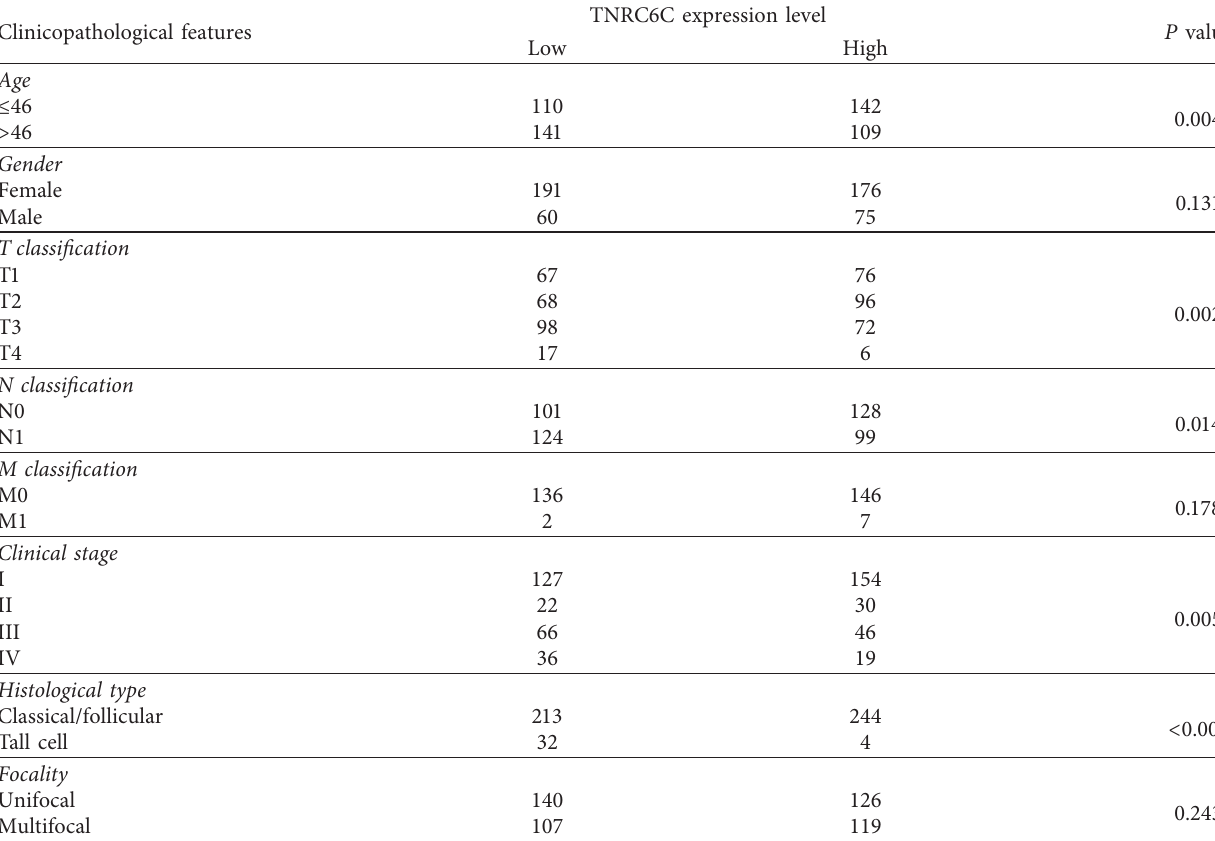
Table 2: The association of TNRC6C expression with clinicopathological features of PTC in TCGA